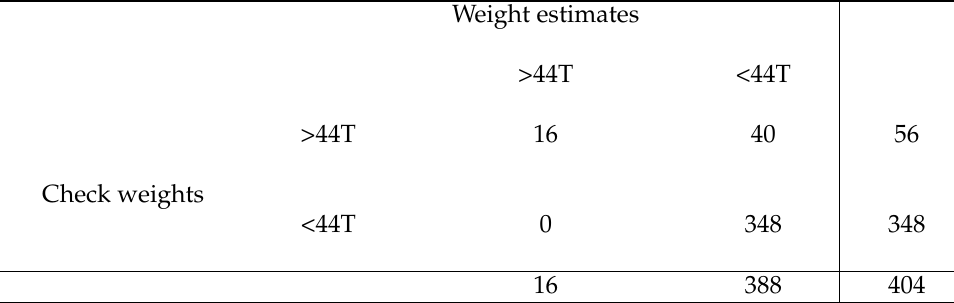
Table 6. Confusion matrix for valid